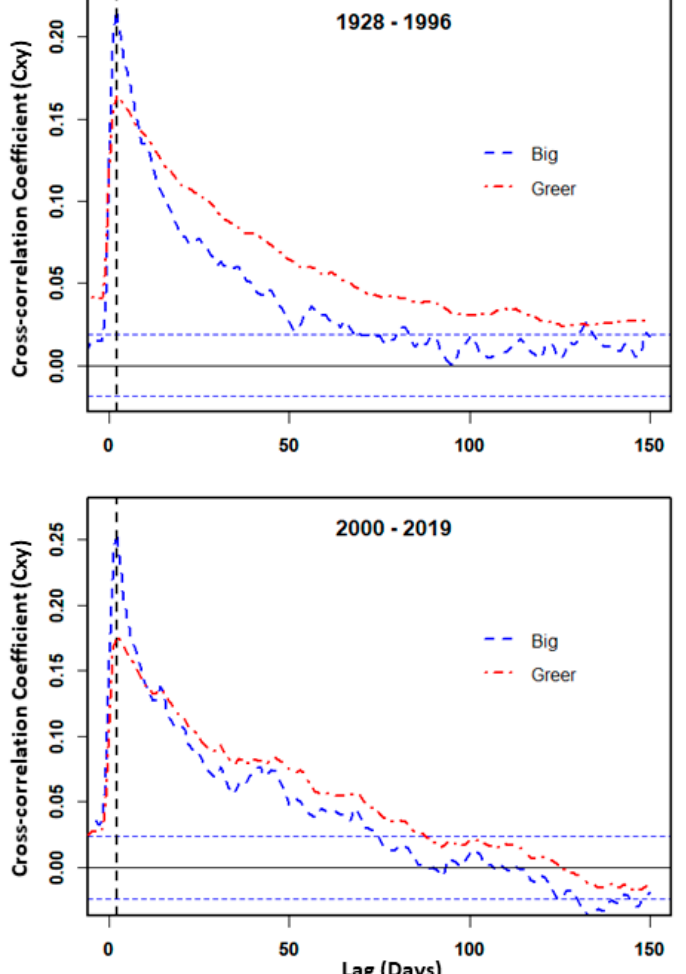
Figure 10. Cross-correlation plots for rainfall at West Plains and discharge at Big and Greer springs for 1928–1996 and 2000–2019, respectively. The horizontal blue dashed lines represent the statistical significance at 95% of confidence intervals.